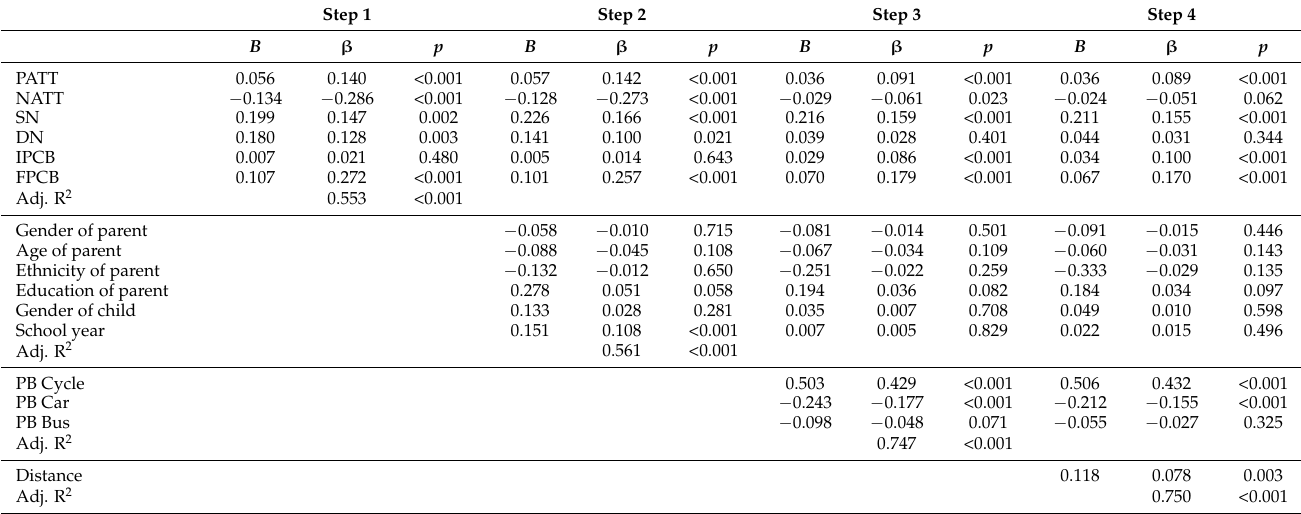
Table 5. Parents’ intention to let the child cycle to school. Hierarchical linear regression